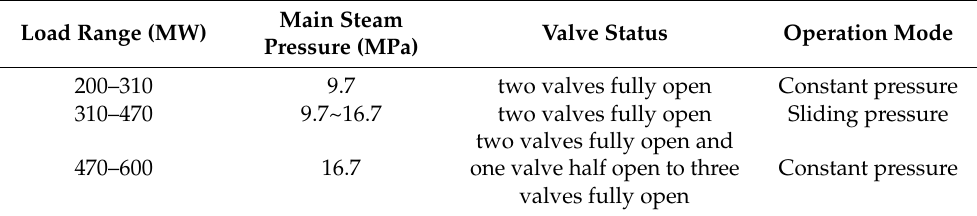
Table 5. Optimized operation mode of steam turbine